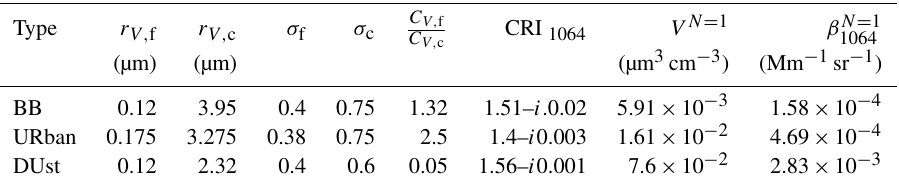
Table 1. Parameters of the biomass burning (BB), URban and DUst particles used in the model. The volume V N = 1 and backscattering coefficient β N = 1 are given for a single particle ( N = 1). 1064